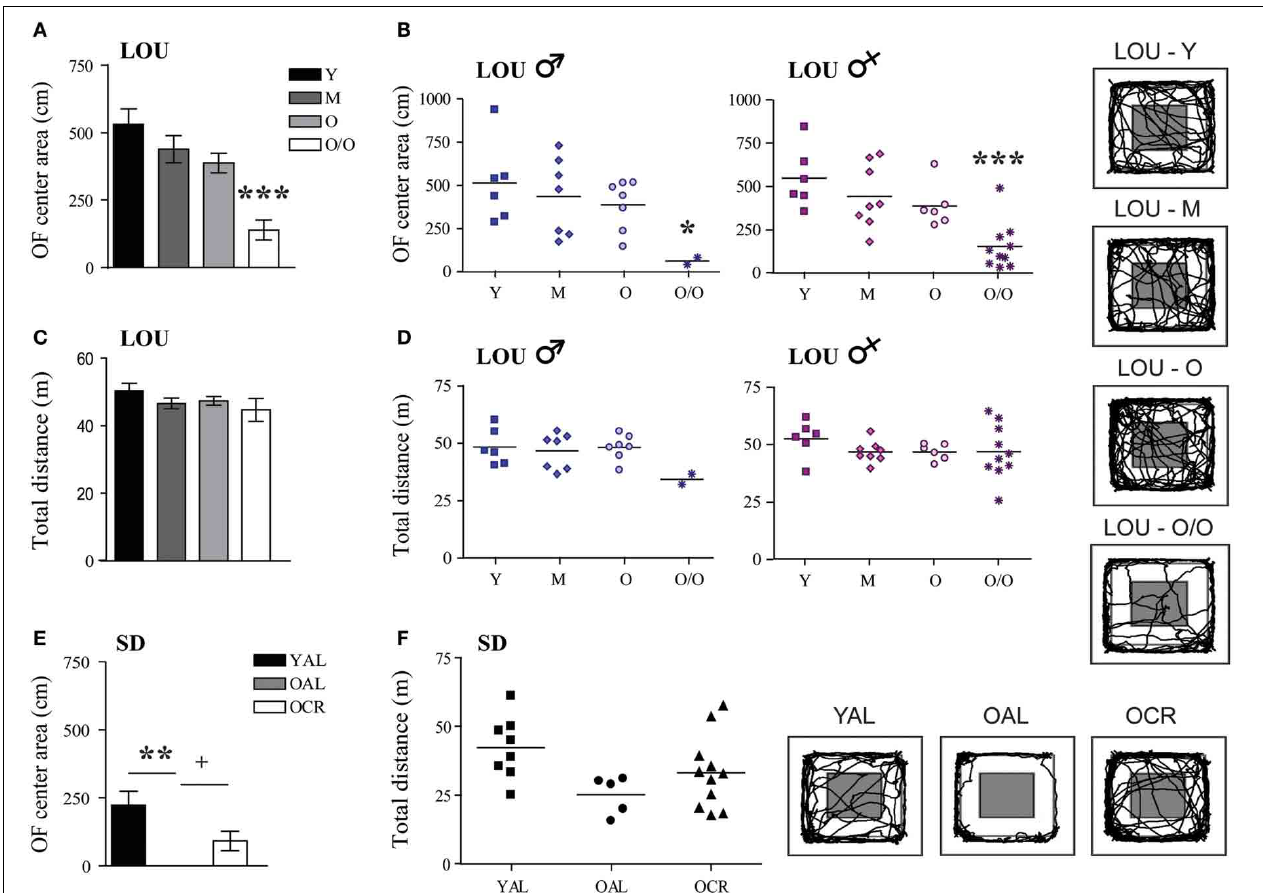
FIGURE 5 | Decreased anxiety-related behavior is observed in old LOU and CR SD rats in the open field task. (A) In contrast to EPM results, O/O LOU rat exploratory behavior in the OF center area of the arena was significantly reduced. (B) This difference was observed in both O/O males and females. Representative paths are shown (center area in gray). Neither aging (C) nor gender (D) affected total distances traveled. (E) OAL SD rats did not explore the center area, suggesting high anxiety as in the EPM